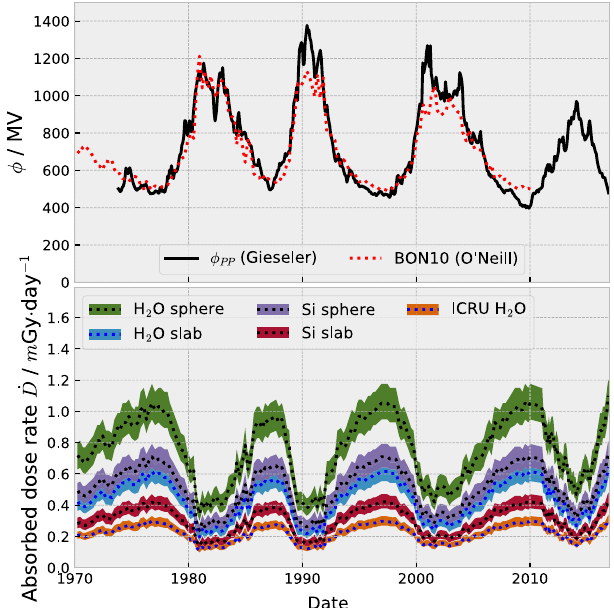
Fig. 7. The upper panel shows the / parameter values by O ’ Neill (2010b) and Gieseler et al. (2017). In the lower panel, we show the time pro fi le of absorbed dose rate due to GCR calculated with equation (6) while using the BON10 / values for the period before 2010 and the Gieseler et al. (2017) thereafter. The absorbed dose rates seen by the different detectors are indicated with colors. The shaded area around the curves correspond to a 20% uncertainty in the value of / . For more details see